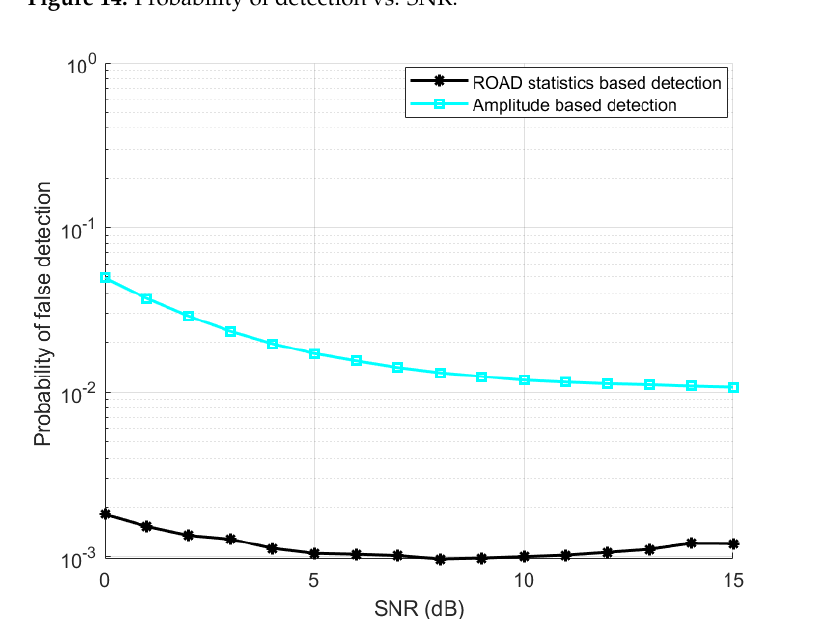
Figure 15. Probability of false detection vs.